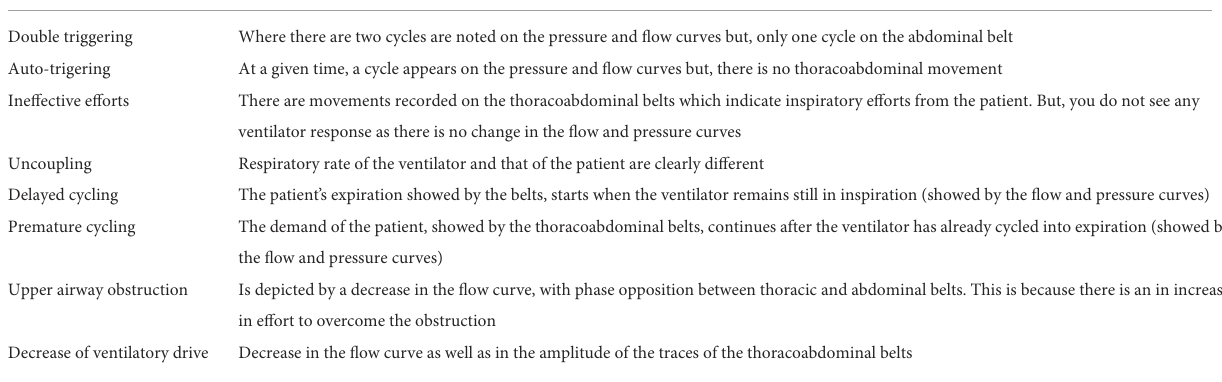
TABLE 1 Types of